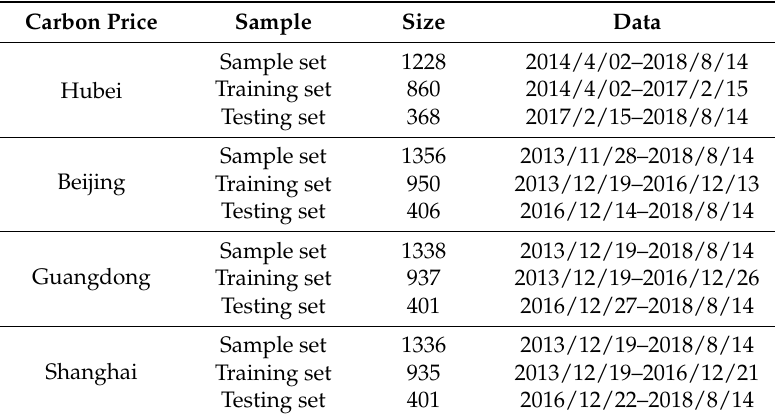
Table 1. Samples of carbon price.